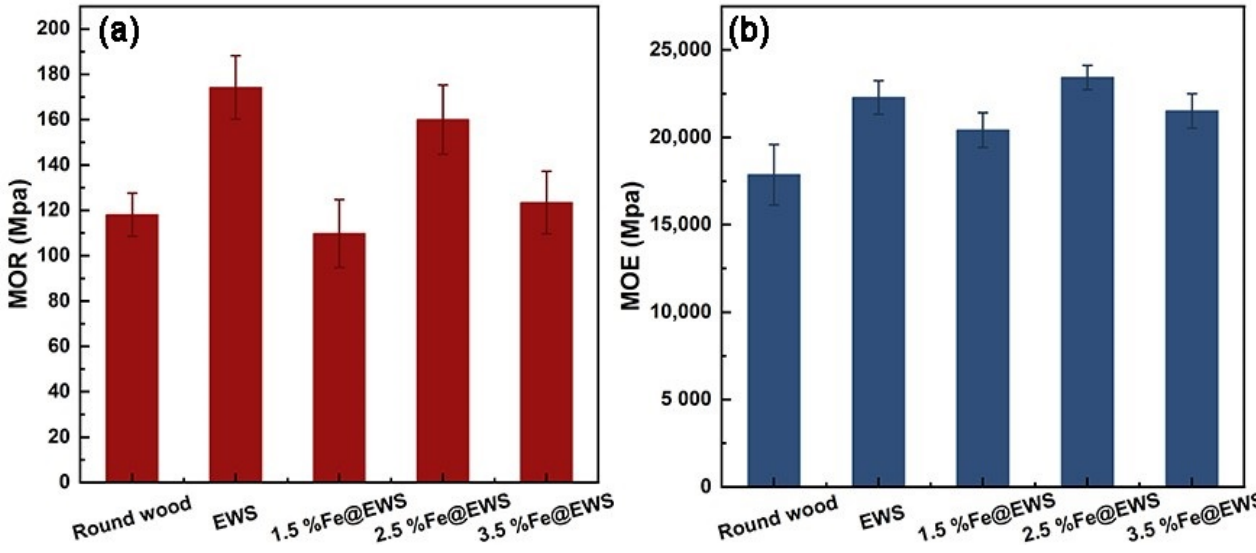
Figure 8. Modules of rupture (MOR) ( a ) and modules of elasticity (MOE) ( b ) of round wood, EWS, 1.5%Fe@EWS, 2.5%Fe@EWS, and 3.5%Fe@EWS.